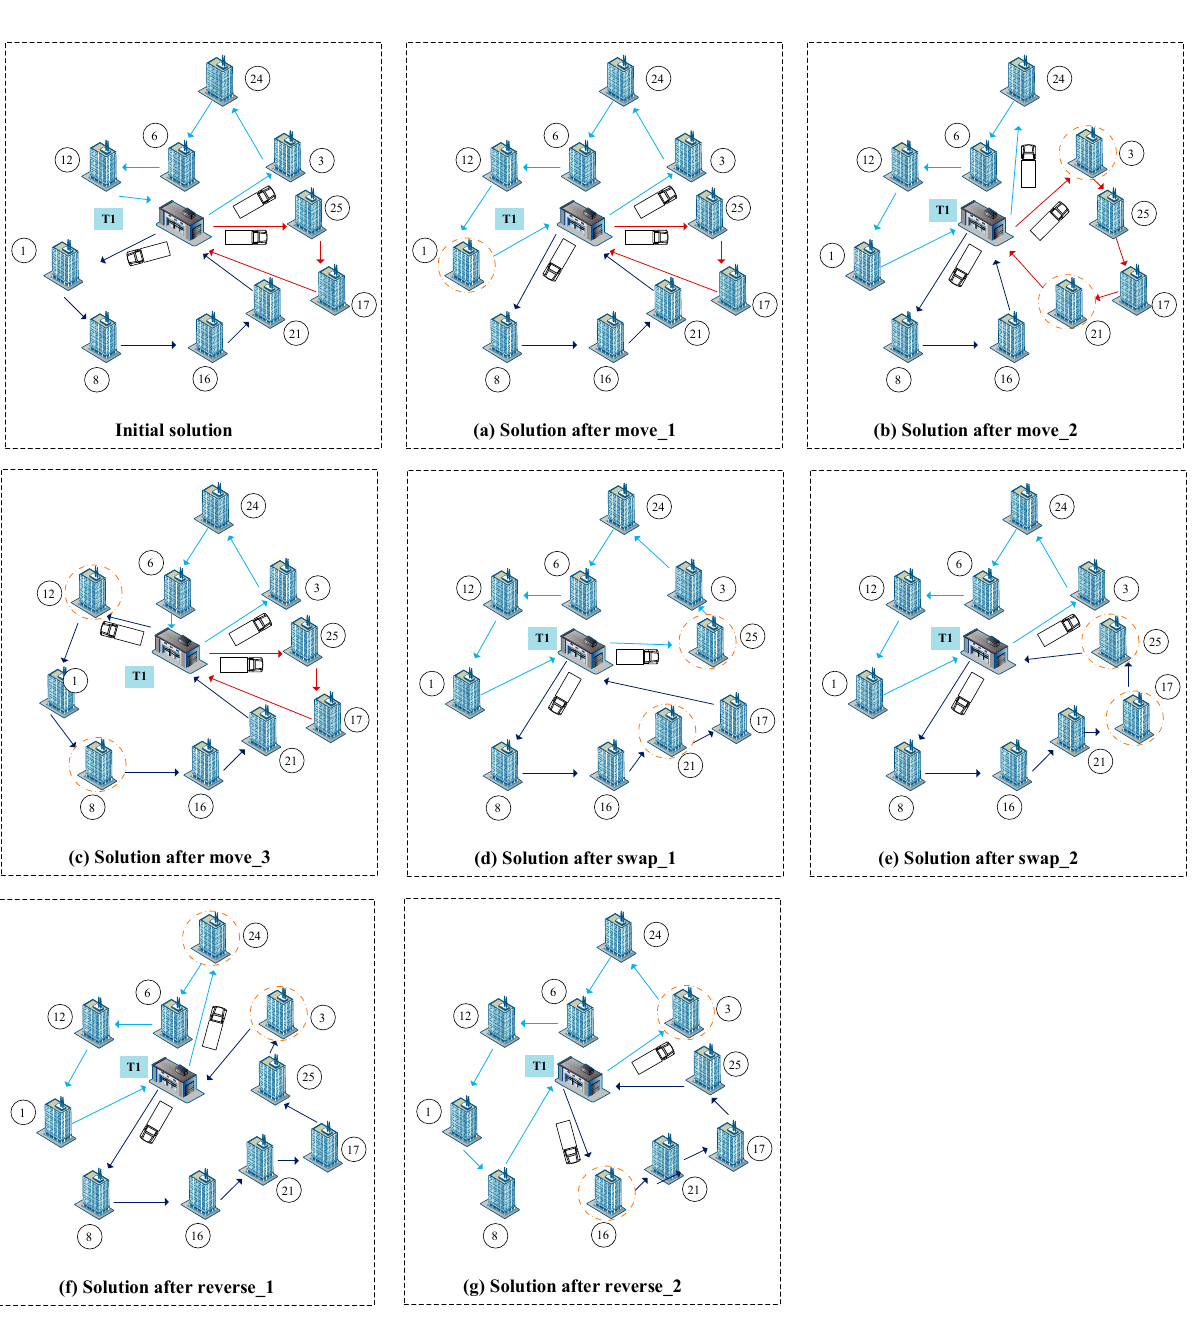
Figure 6. New solution after local search